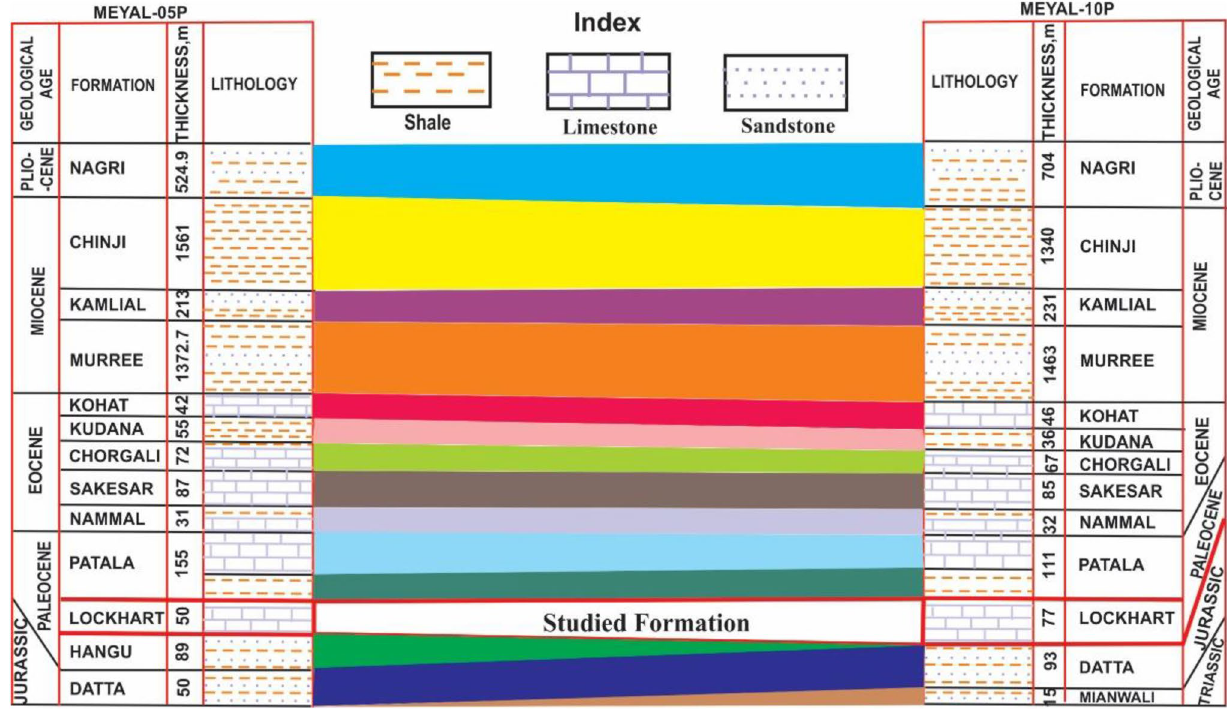
Fig. 3 Stratigraphic correlation chart of Meyal-05P and Meyal-10P wells, Meyal Oil